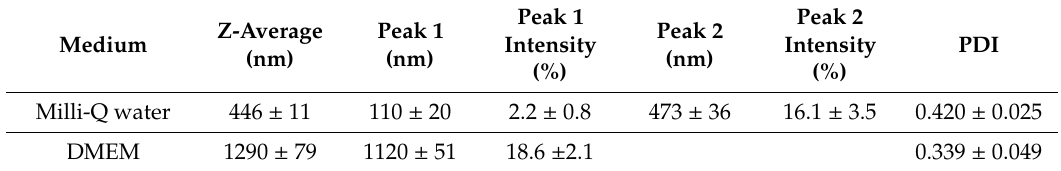
Table 1. Size distribution of titanium dioxide nanoparticle (TiO 2 NP) suspensions in Milli-Q water and Dulbecco’s modified minimum essential medium (DMEM).